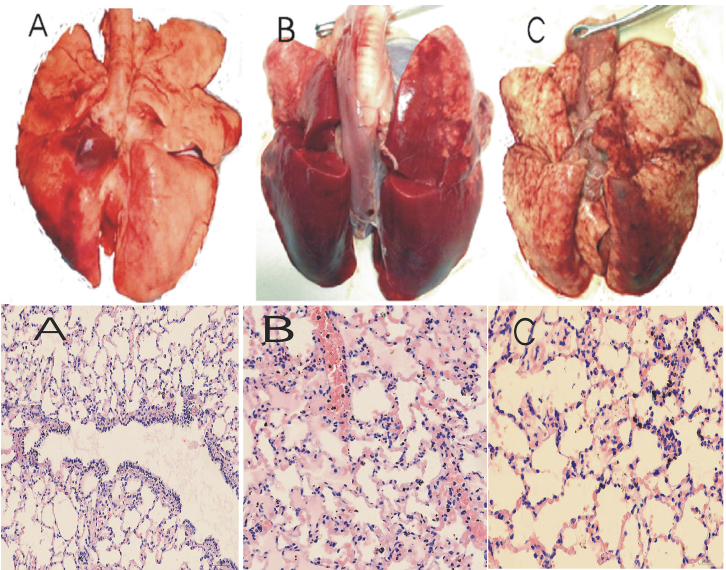
Fig 5. Histopathological examination. Representative appearances and photomicrographs of hematoxylineosin – stained lung sections (magnification ×200) from control group (A, n = 6), BIPAP SB = biphasic positive airway pressure with SB (B, n = 6), and BIPAP AP = biphasic positive airway pressure with abdominal muscles paralysis (C, n = 6).The control group had minimal alveolar congestion, and inflammatory cell infiltration. The BIPAP AP group showed mild thickening of the alveolar walls, alveolar congestion, and hemorrhage. In the BIPAP SB group, inflammatory cell infiltration, thickening of the alveolar walls, alveolar congestion, and more prominent hemorrhagic areas were